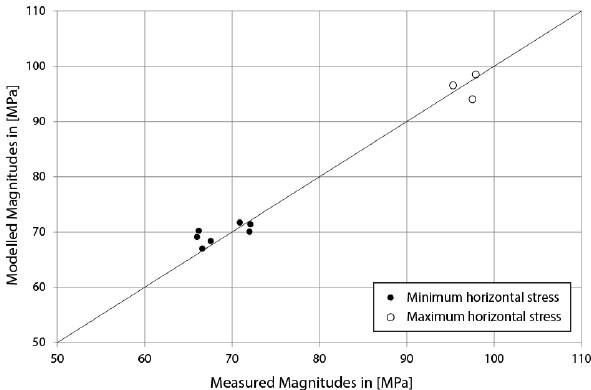
Fig. 6. Correlation between measured and modelled magnitudes of the minimum and maximum horizontal stress. Measured stresses were derived from hydraulic fracturing and ultrasonic wave velocity analyses on drill cores. For a perfect fit, all points would lie on the bisecting line of the